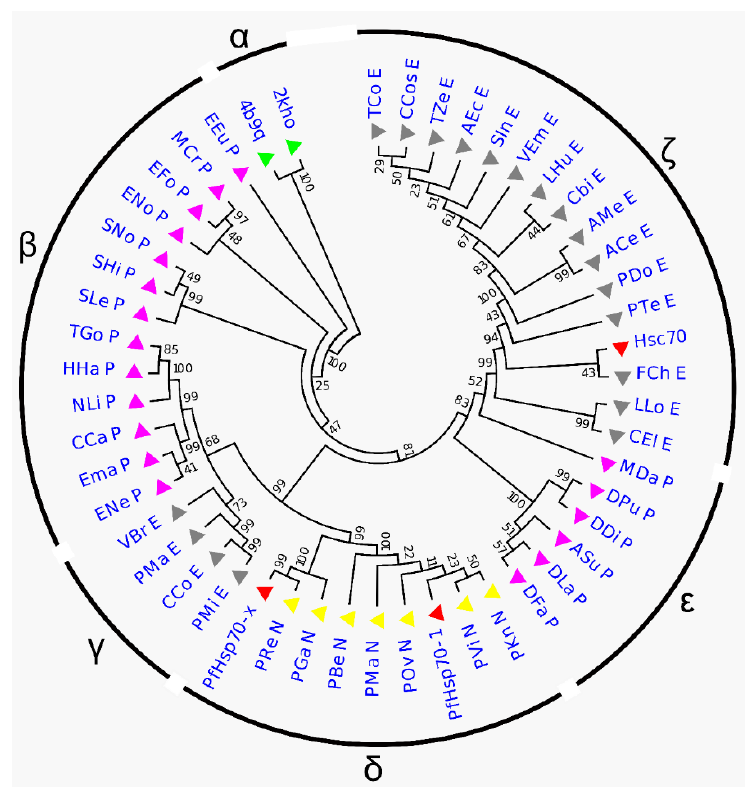
Figure 1. Maximum likelihood phylogenetic tree based on Hsp70 sequences showing the relationship between host (Hsc70) and parasitic proteins (PfHsp70-x and PfHsp70-1). Color code: Red: PfHsp70-x, PfHsp70-1, and Hsc70; purple: 7 non-falciparum (plasmodial); grey: 19 Protozoan (non-plasmodial); blue: 19 Eukaryotic (non-protozoan); yellow: 2KHO and 4B9Q. Percentage recurrence of 1000 bootstrap tests is indicated next to the branches.